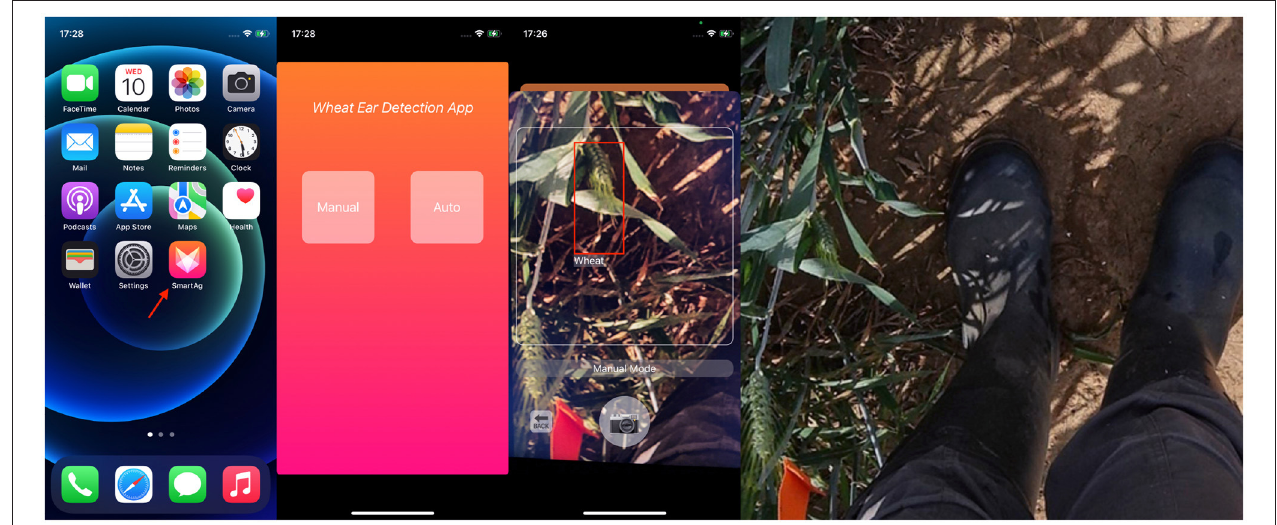
FIGURE 9 | Screenshot on iPhone12 mini. From left to right: screenshot of the app launched on the desktop; screenshot of the function selection after launching; screenshot of the test result; and image of wheat used for testing.